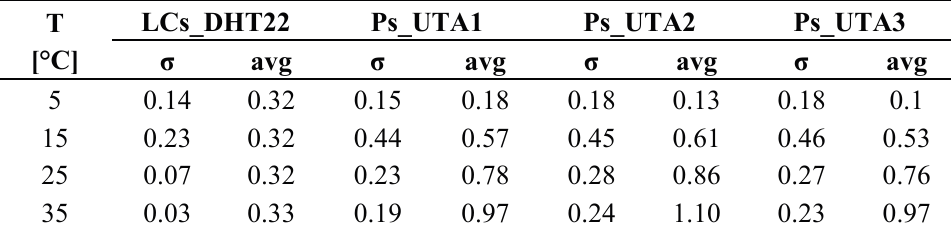
Table 3. Residuals analysis of the temperatures: standard deviation ( σ ) and average (avg) of the values detected by LCs and Ps related to climatic box